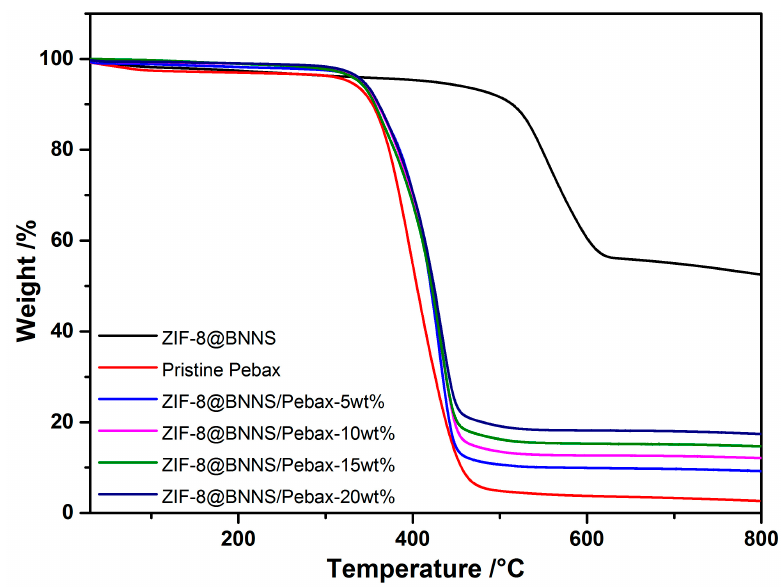
Figure 4. TGA curves of ZIF-8@BNNS and ZIF-8@BNNS/Pebax membranes.